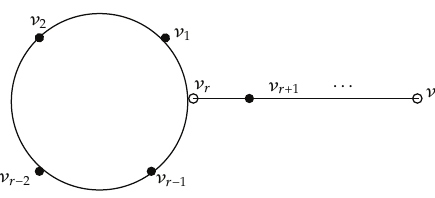
Figure 1: The graph G . (cid:2) All 2-cycles in G are negative, r is odd, 3 ≤ r ≤ n (cid:3)